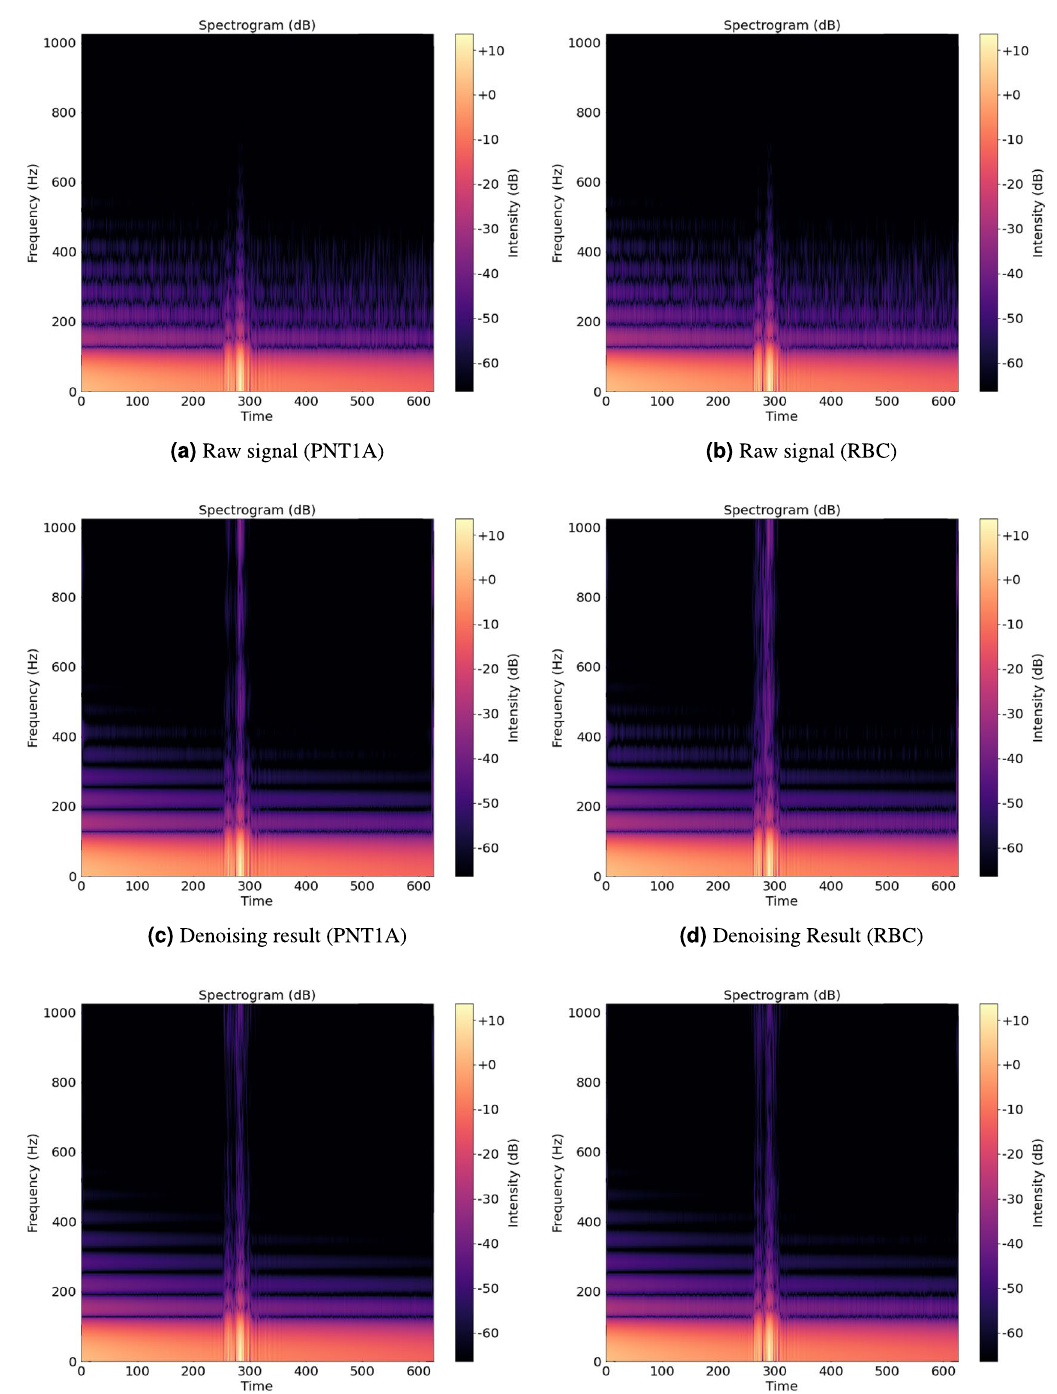
Figure 4. Results of the proposed denoising autoencoder models. Figures on the left side are spectrograms of a PNT1A cell, and spectrograms of an RBC are on the right side. The X and Y-axes indicate time and frequency, respectively. Furthemore, the brightness of colors refers to the intensity of the frequency components. The time unit corresponds to 16 samples in the signal, and the units of frequency and intensity are Hz and dB , respectively. ( a ) and ( b ) are the spectrograms extracted from the original signal, ( c ) and ( d ) are based on our denoising autoencoder using 1D CNN, and ( e ) and ( f ) are cases in which the denoising autoencoder and Gaussian noise injection were used